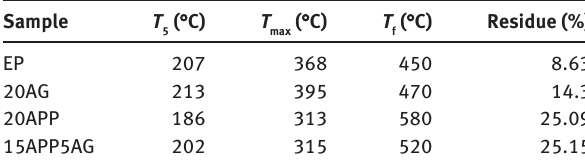
Table 2: TGA data of neat epoxy and epoxy composites. Sample